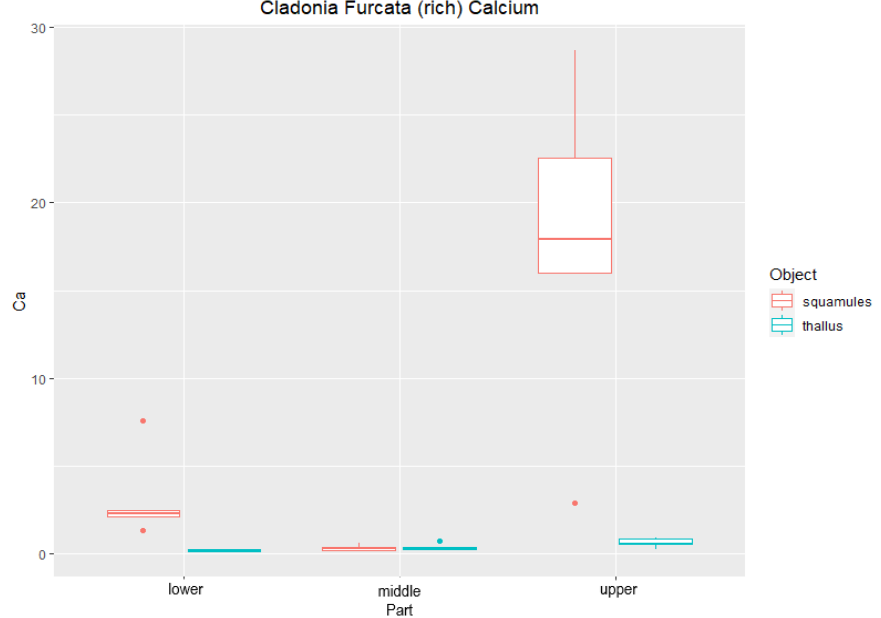
Figure 2. Content of Ca (DW%) in lichen thallus and squamules of Cladonia furcata collected from calcium-rich sites ( n = 5). “Lower”, “middle”, and “upper” designate the location of the mea- sured